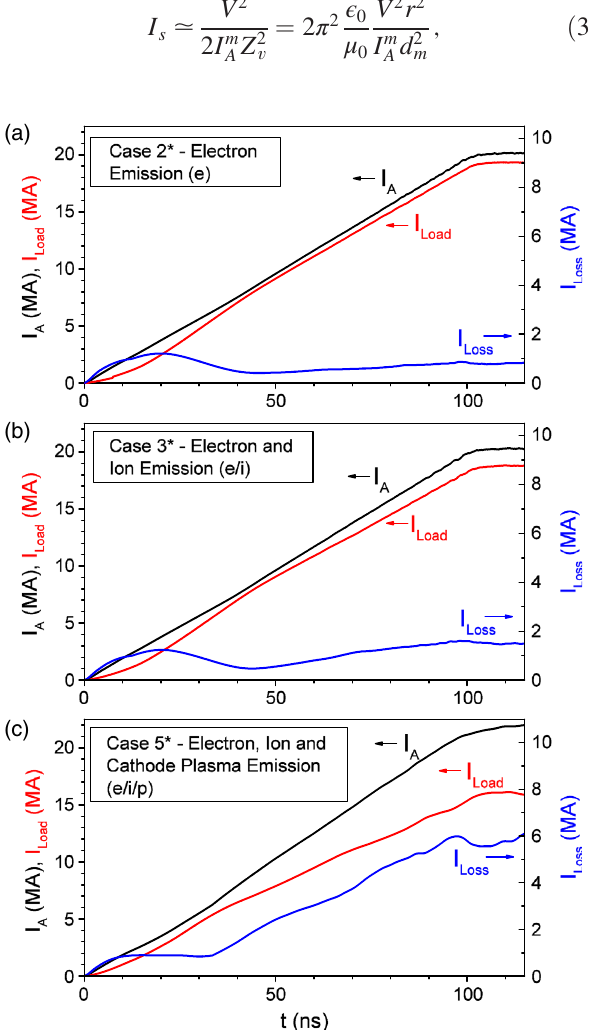
FIG. 3. Upstream anode current ( I A ), load current ( I loss current I (b) 3*, and